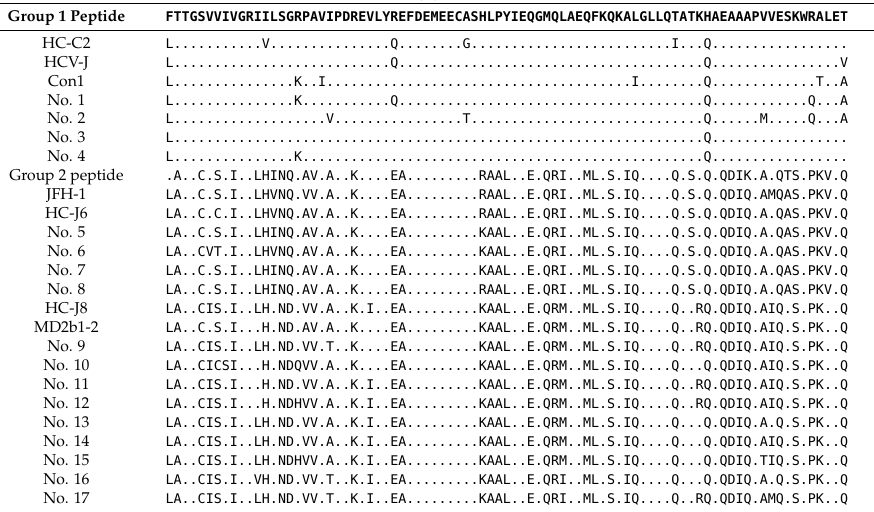
Table 5. ( A ) Comparison between consensus NS4 amino acid sequences obtained from discrepant samples, group-specific peptides and reference sequences by cloned Sanger sequencing; ( B ) Comparison between epitope regions of NS4 amino acid sequences from genotype 1b samples and those of group 1 peptide by cloned Sanger sequencing; ( C ) Comparison between epitope regions of NS4 amino acid sequences from samples of genotype 2a, 2b and those of Group 2 peptide by cloned Sanger